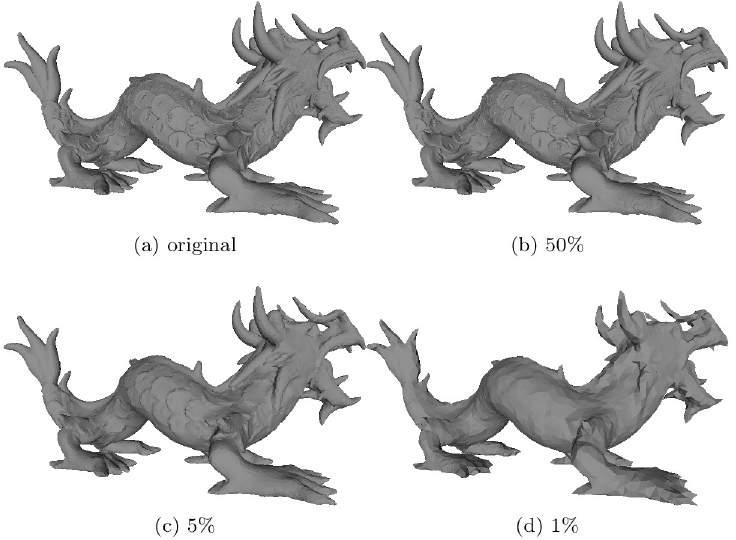
Fig 6. The simplification of the Dragon into different levels of detail. (a) The original dataset, (b) 50% of vertices, (c) 5% of vertices, and (d) 1% of vertices.